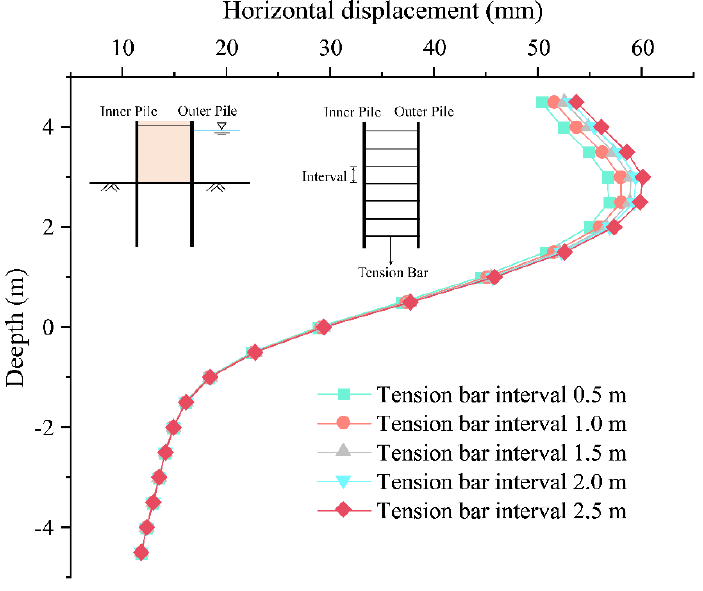
Figure 18. Pile horizontal displacement of different tension bar interval conditions.